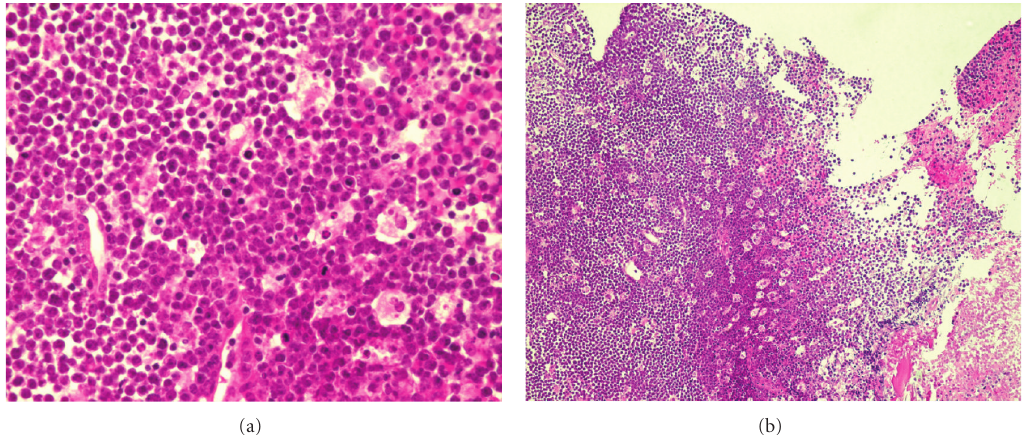
Figure 3: Tumor cells of large size admixed with numerous macrophages containing apoptotic bodies (“starry sky” aspect).